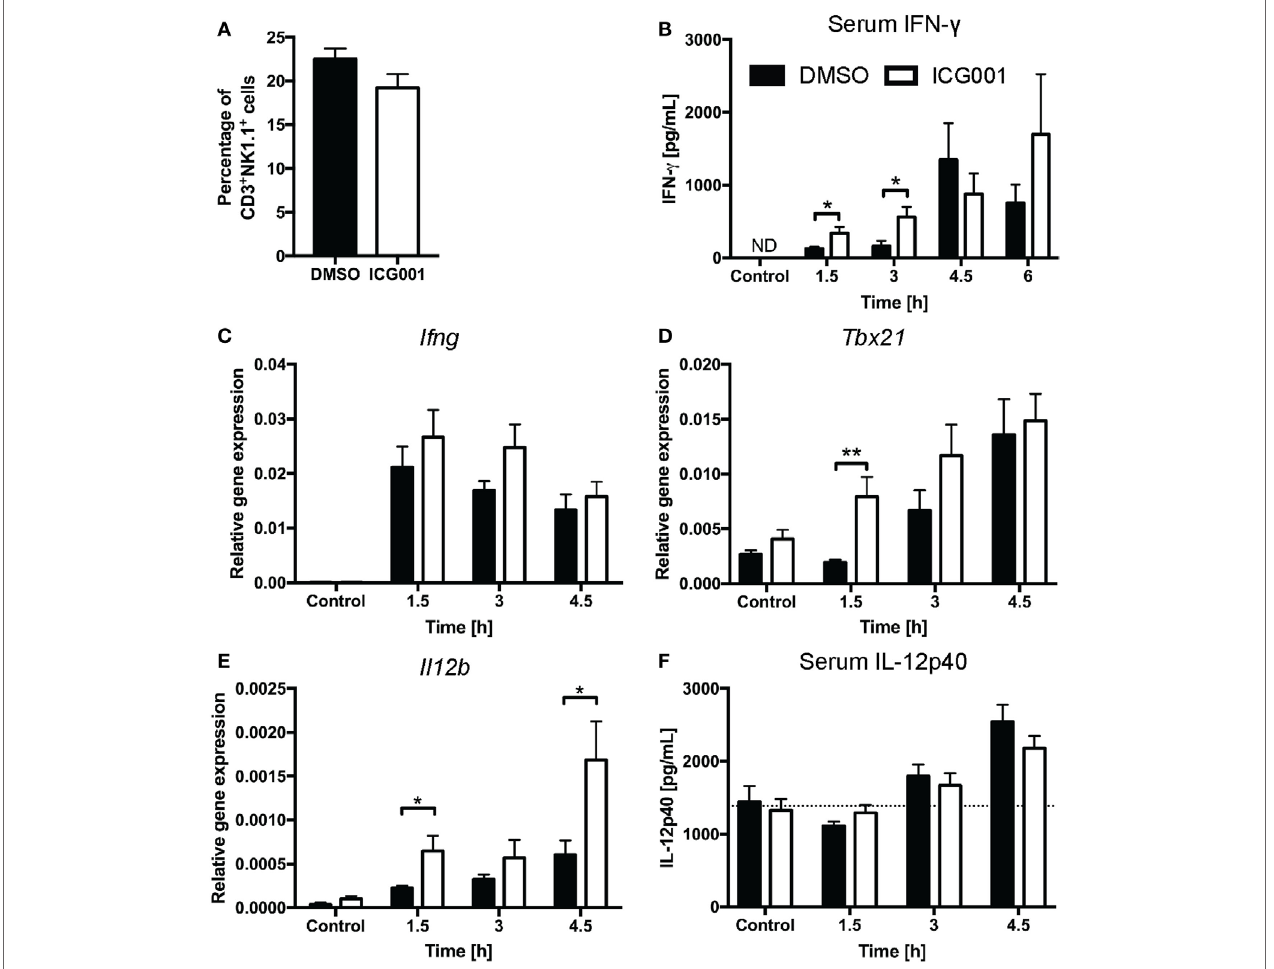
FigUre 3 | β -catenin activity suppresses the IL-12/interferon gamma (IFN- γ ) axis upon α -galactosylceramide ( α -GalCer) challenge. (a) Percentages of CD3 + NK1.1 + natural killer T cells in liver tissue after overnight challenge with ICG001, an inhibitor of β -catenin activity, or DMSO. After α -GalCer challenge, (b) serum concentrations of IFN- γ were determined by ELISA. The mRNA expression of Ifng (c) and Tbx21 (D) in the liver was determined by quantitative RT-PCR. (e) mRNA expression of Il12b in the liver and (F) protein expression of IL-12p40 in the serum. Dotted line represents average concentration of serum IL-12p40 for all mock-injected mice. Data are means ± SEM from four to nine mice per treatment for each time point cumulative from two to three independent experiments. Groups were compared by unpaired t test at each time point; * p < 0.05, ** p < 0.01, N.D., not